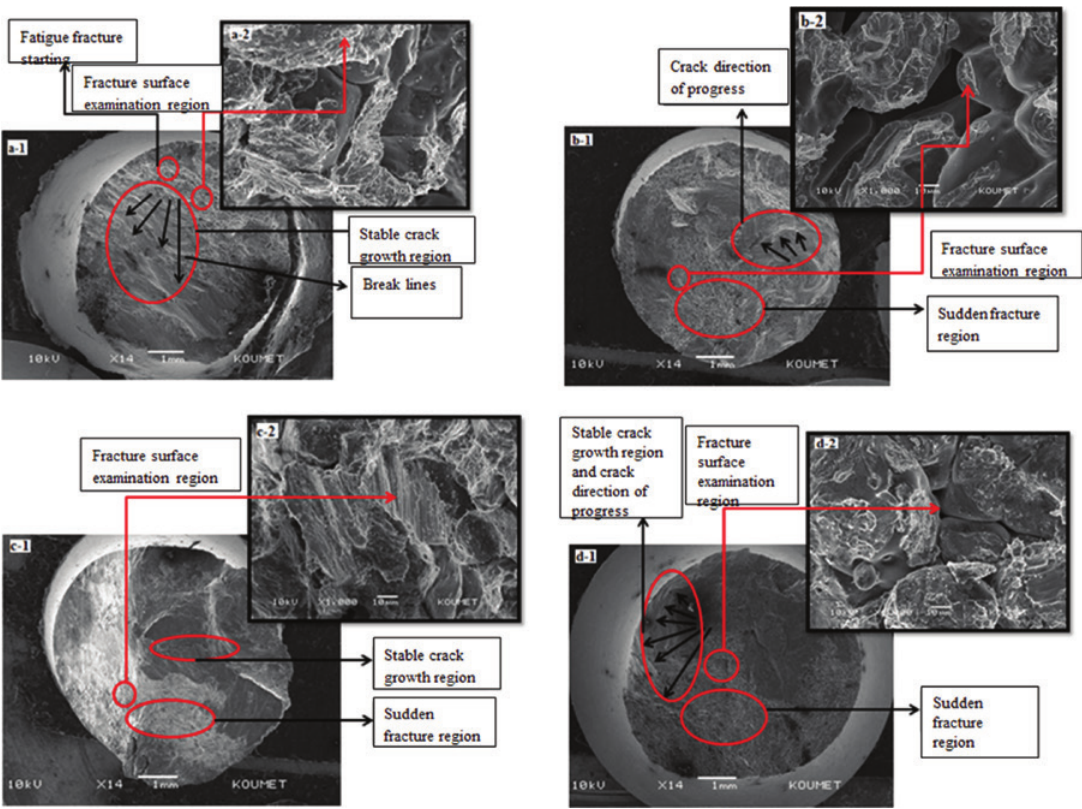
Fig. 9: SEM images of fracture surface morphology of ECAP’ed and thixoformed AA7075 after high cycle fatigue test; 1 passed (a1–a2), 2 passed (b1–b2), 3 passed (c1–c2), and 4 passed